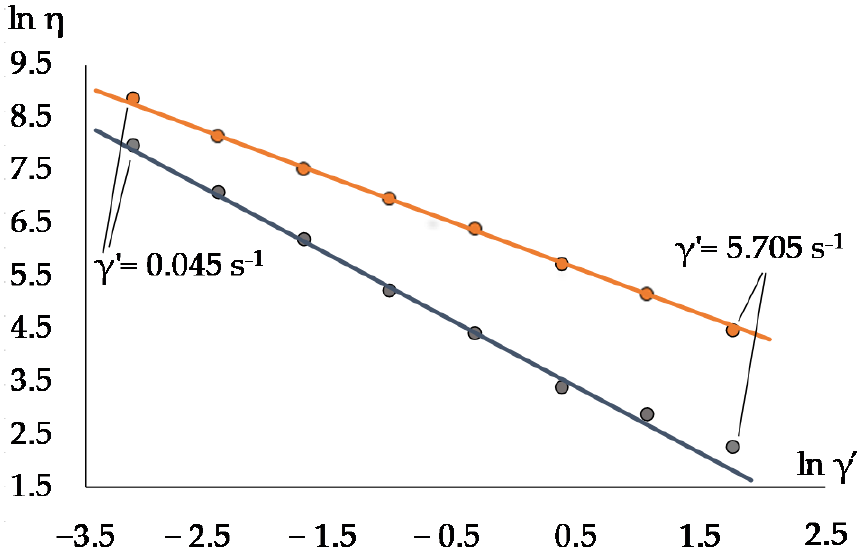
Figure 2. Logarithmic dependences of the viscosity on shear rate for compositions with minimum and maximum viscosity.